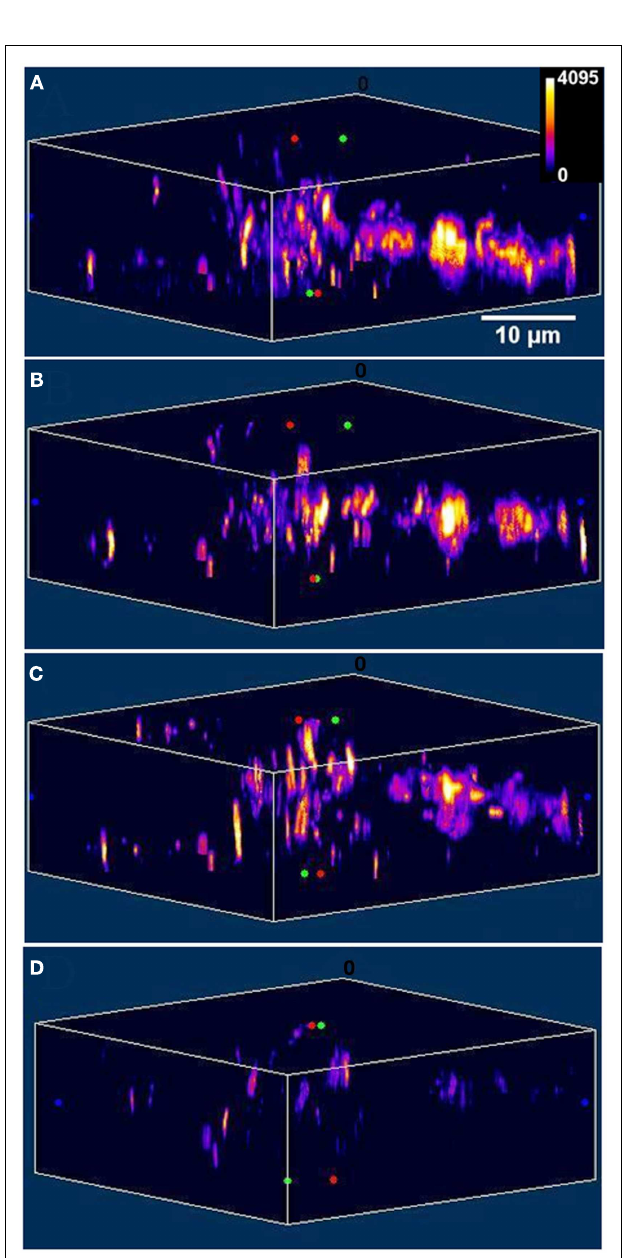
FIGUREA3 | Depolarization induces exocytosis of FM 1-43 labeled vesicles. X - Z slices of the images of FM 1-43 labeled vesicles in a cultured serotonergic neuron (A) before, and (B–D) 5, 15, and 30min after depolarization respectively (Intensities are false color